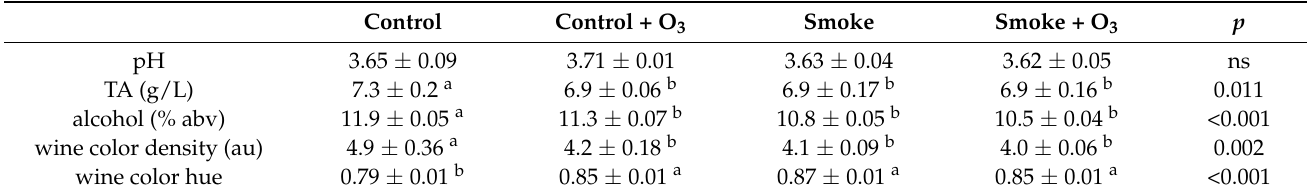
Table 2. Basic chemistry of Cabernet Sauvignon wines made with control or smoke-exposed grapes, with or without post-harvest ozone treatment (1 ppm for 24 h).